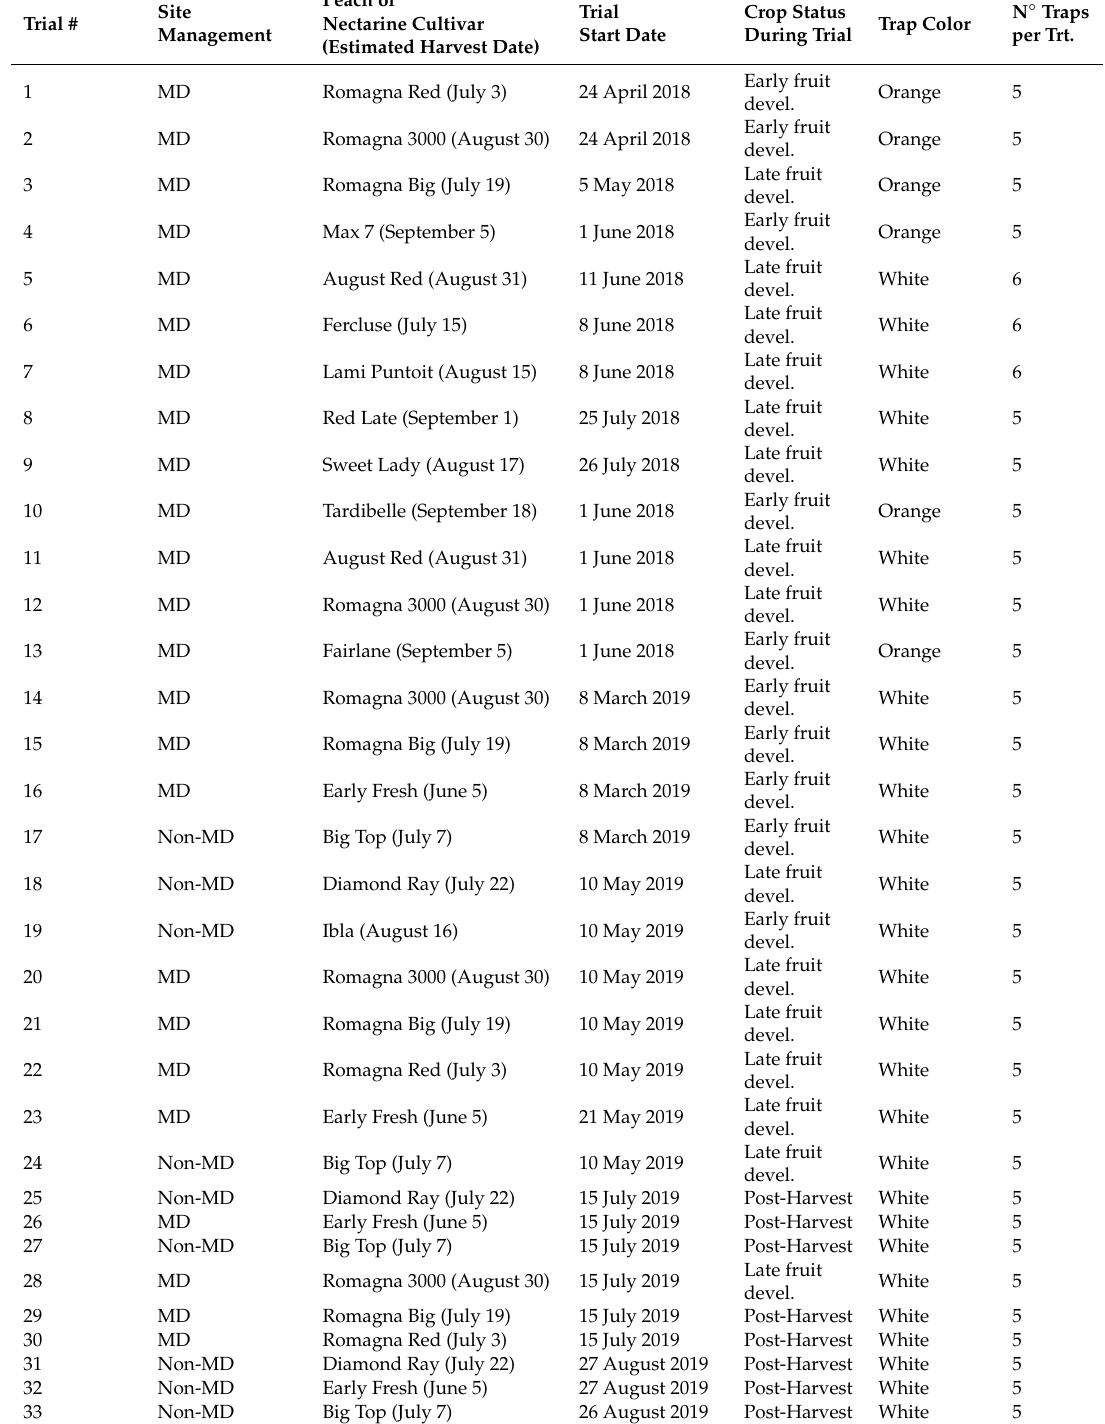
Table 1. Thirty-three trials of lure comparison to improve Grapholita molesta monitoring in peach and nectarine orchards treated and not treated with Mating Disruption (MD). Trials were performed at di ff erent crop phenological stages (according to the BBCH scale), including early fruits development (from blooming until fruits at half final size, BBCH 71-76), late fruit development (fruits increasing in size up to ripeness, BBCH 77-87) and in post-harvest (after BBCH